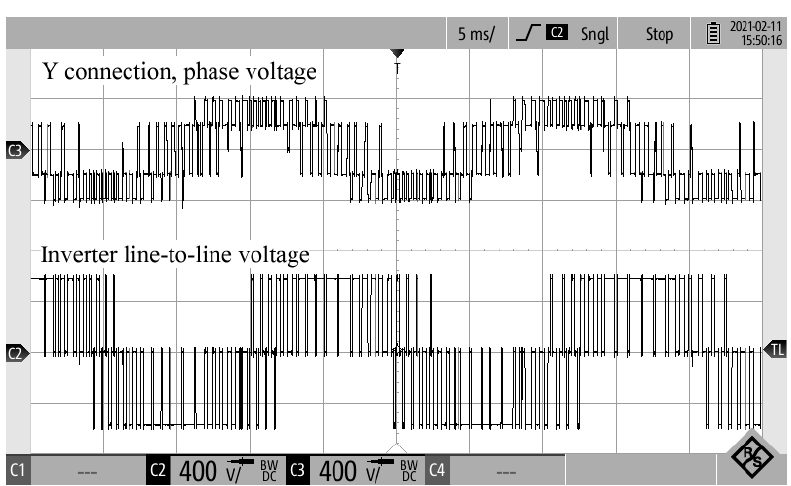
Figure 16. Comparison of the motor phase voltage in a star configuration with the inverter line-to-line voltage (i.e., the phase voltage for a delta configuration); DC-link voltage 560 V.